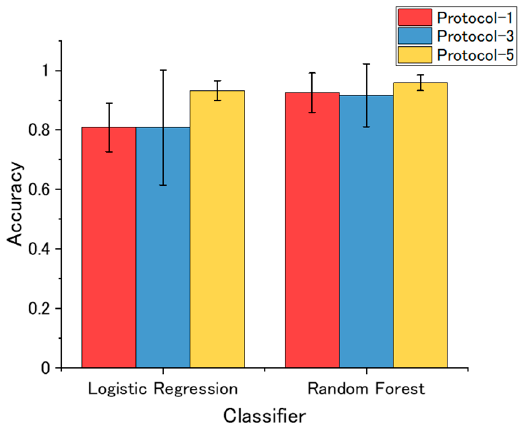
Figure 6. Summary of the classification models.